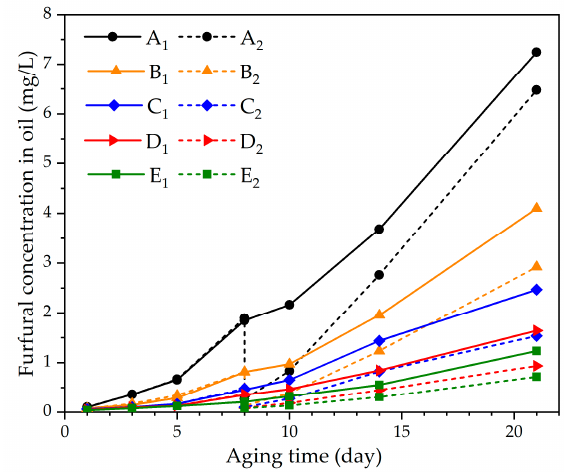
Figure 4. The relationship between furfural concentration in oil and aging time.